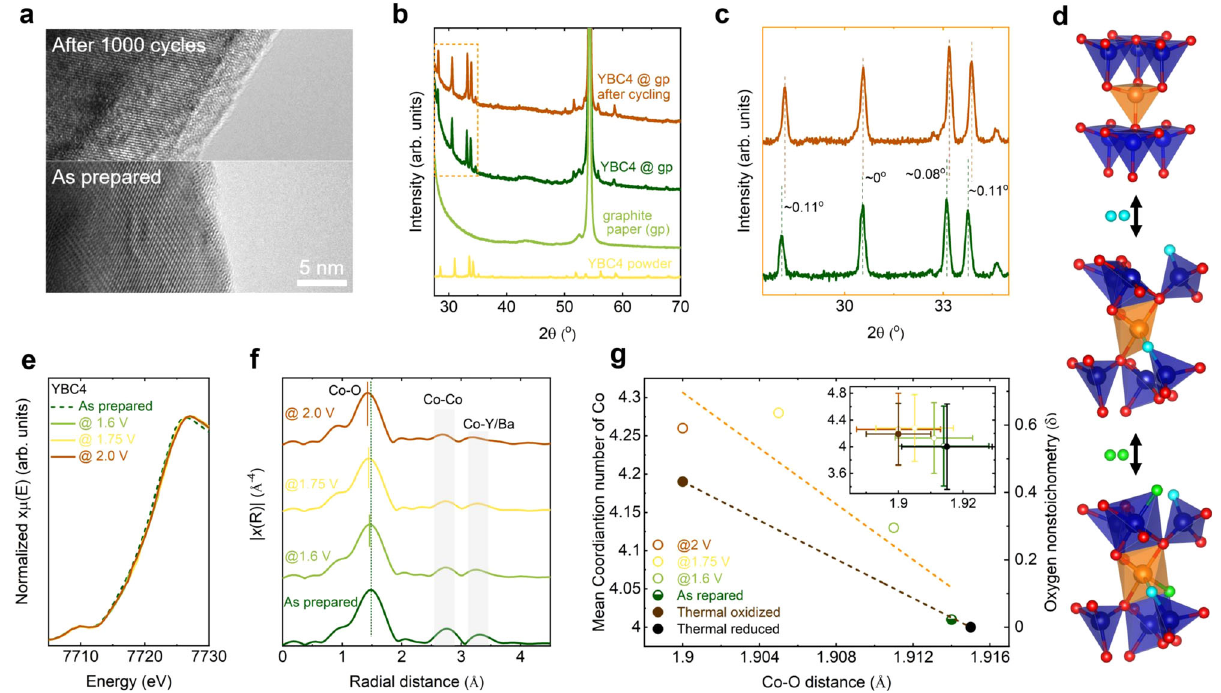
Fig. 3 | Enhanced stability by the fl exible structure. a HRTEM images of surface structures from the as-prepared YBC4 and 1000-cycled YBC4. b The XRD patterns of the as-prepared YBC4 powder, electrode substrate of graphite paper (gp), and YBC4@gpbeforeandafter1000cyclesofCVcycling. c Thedetailsofpeakshiftsin the XRD patterns of YBC4@gp before and after CV cycling. d An oxygen inter- calation process in the YBC4 lattice. The sky-blue spheres and green spheres represent oxygen atoms inserted into the lattice. e Measured Co K-edge XANES of the as-prepared and electrochemically oxidized YBC4. f k 3 -weighted Co K-edge